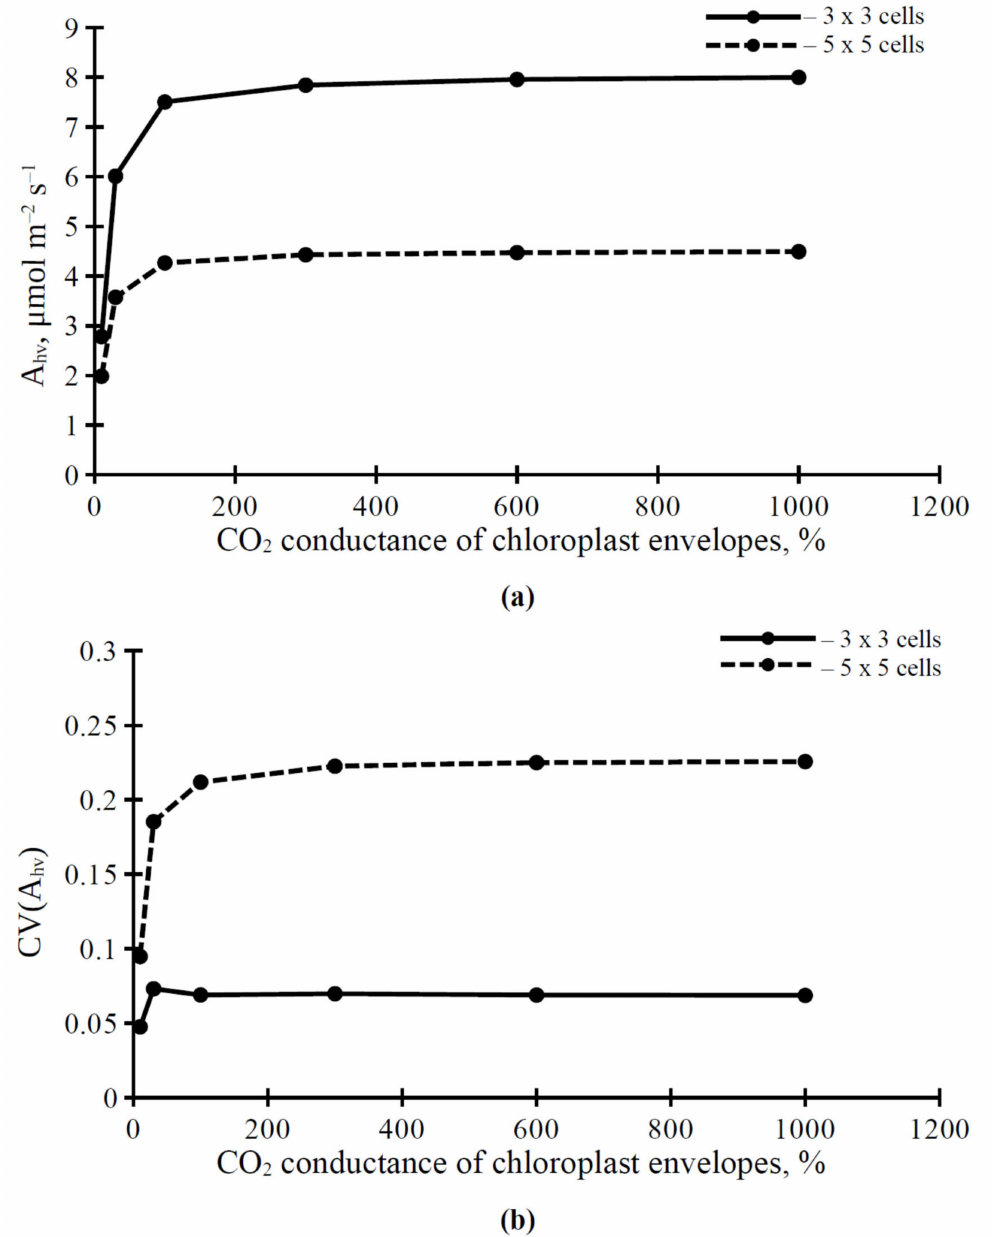
Figure 6. Dependence of the photosynthetic CO 2 assimilation rate (A hv ) ( a ) and the coefficient of variation of the spatial distribution of this rate (CV(A hv )) ( b ) on the CO 2 conductance of chloroplast envelopes under PAR intensity equaling to 221 µ mol m − 2 s − 1 . Each stomata in the simulated leaf was located in center of a 3 × 3 cell square or in center of a 5 × 5 cell square. The value of the CO 2 conductance of chloroplast envelopes from our previous work [42] was used as